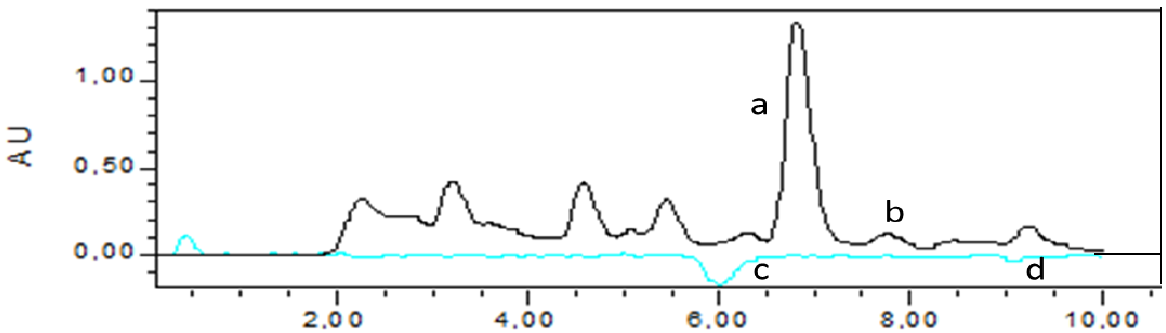
Figure 5. Chromatogram of G . Lutea root extract obtained direct and from the post-column HPLC-ABTS •+ radical scavenging method. ( a ) Gentiopicroside; ( b ) Sweroside; ( c ) antiradical activity by unknown compound; 31.33 ± 1.16 mg GAE/L and ( d ) antiradical activity by unknown compound; 8.30 ± 0.12 mg